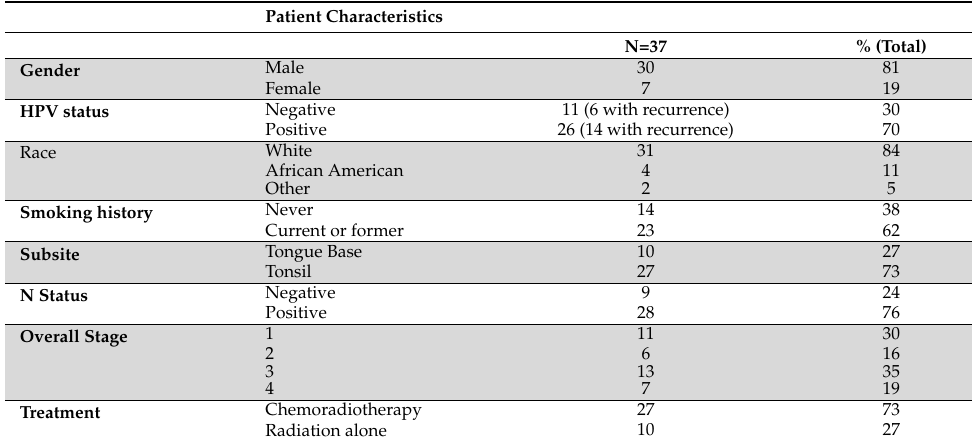
Table 1. Patient Demographic and Clinical